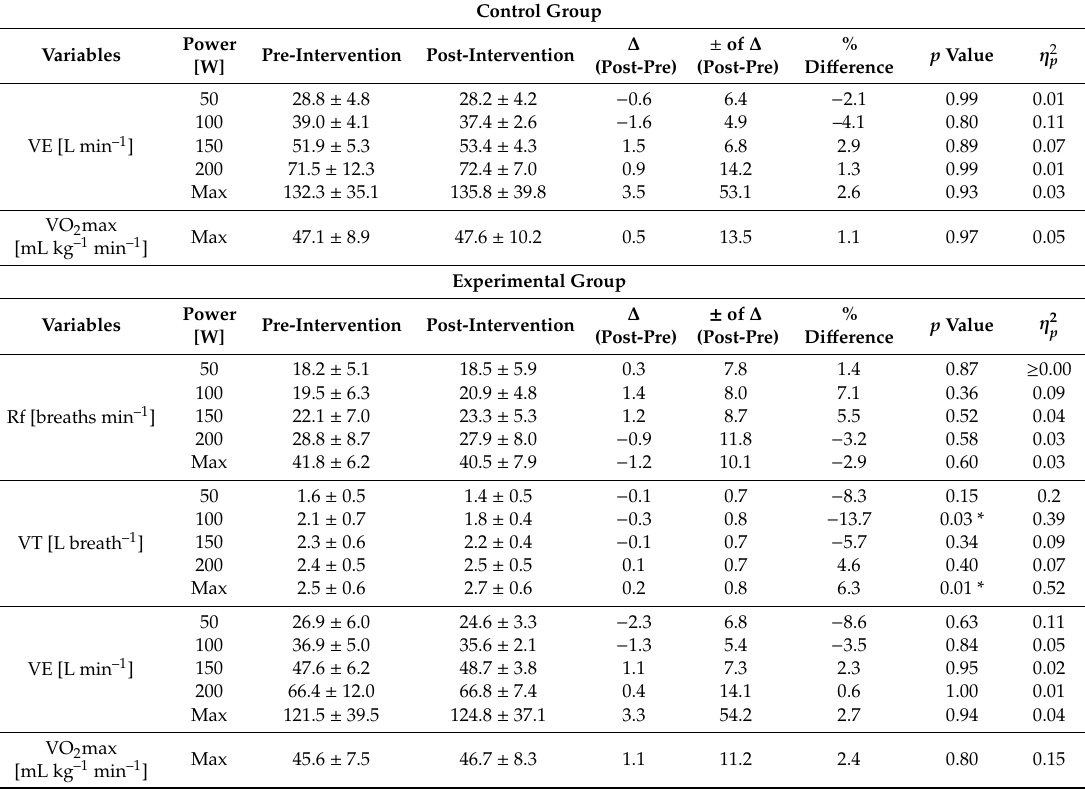
= 0.52) (Table 3). Pre- and postintervention p